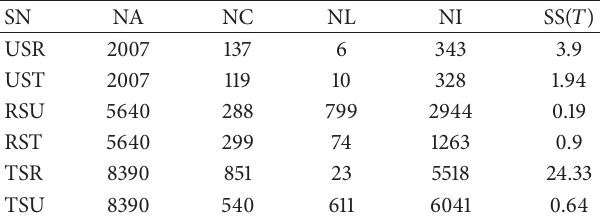
Table 5: Precision of the six